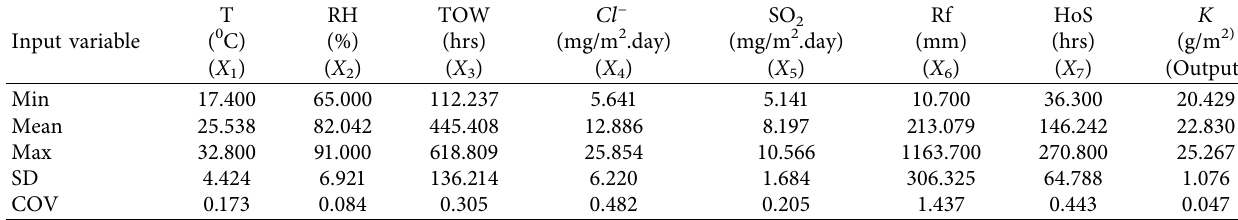
Table 1: Statistic properties of the experimental